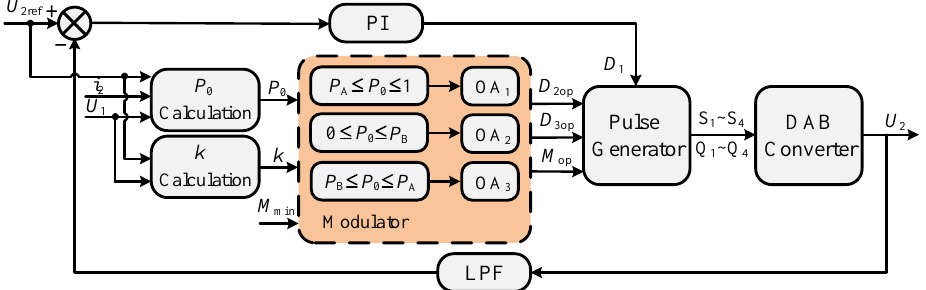
Figure 13. Control diagram of TPSiDT scheme.